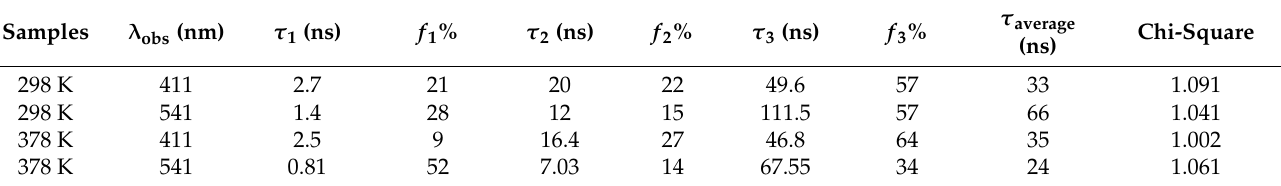
Table 2. The observed excited-state PL lifetime for different ZnO–SiO 2